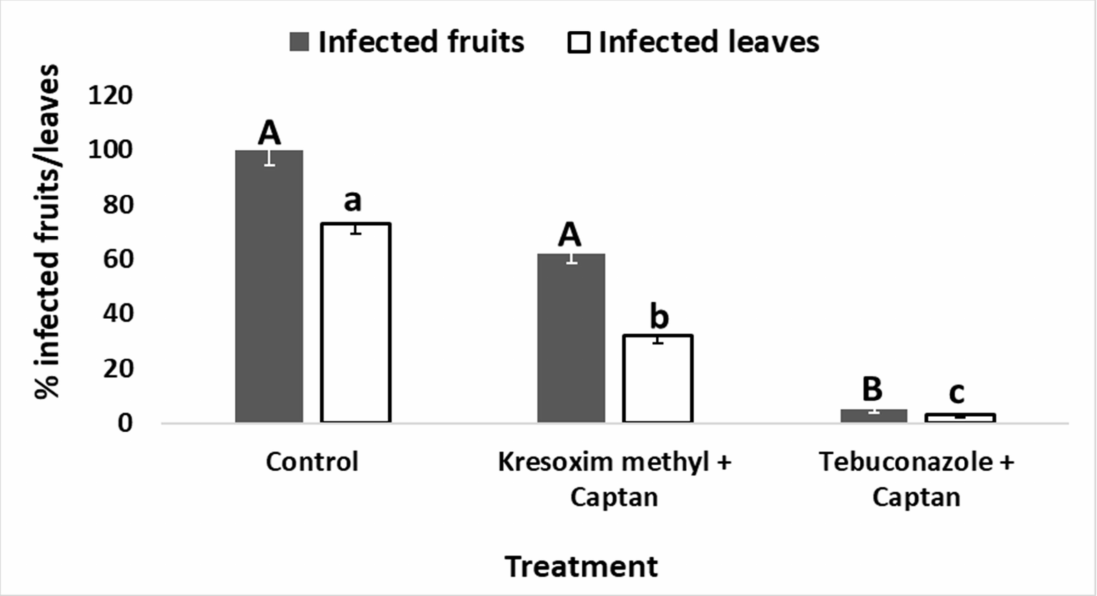
Figure 4. Activity of strobilurin and triazole fungicides in mixtures with captan on apple scab development in the Alonei Ha’bashan orchard in 2011. The tank mixture of kresoxim-methyl at 0.015% ( w/v ) + captan 0.25% ( w/v ), and the prepacked mixture Orpan at 0.3% (containing tebuconazole + captan) were tested. Bars represent the standard error of the mean. Different letters on the bars indicate significant differences ( p < 0.05) according to Fisher’s LSD K-ratio t